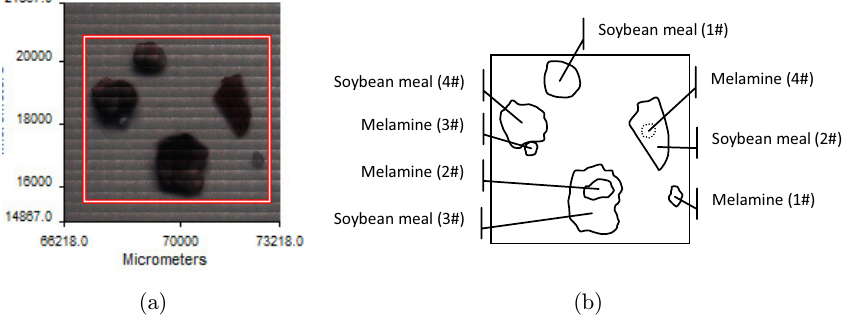
Fig. 1. Five arrangement statuses for the particles from soybean meal and melamine. (a) Visible light image. (b) Schematic of ¯ve arrangement